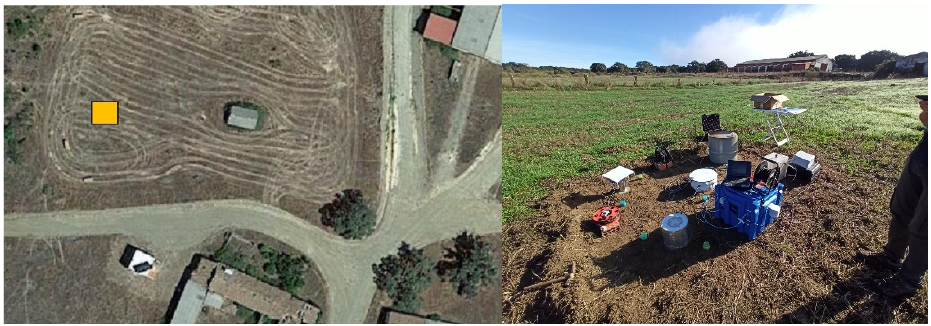
Figure 2. Aerial view and picture of the devices placed in the high radon flux area. The yellow rectangle indicates the testing area.